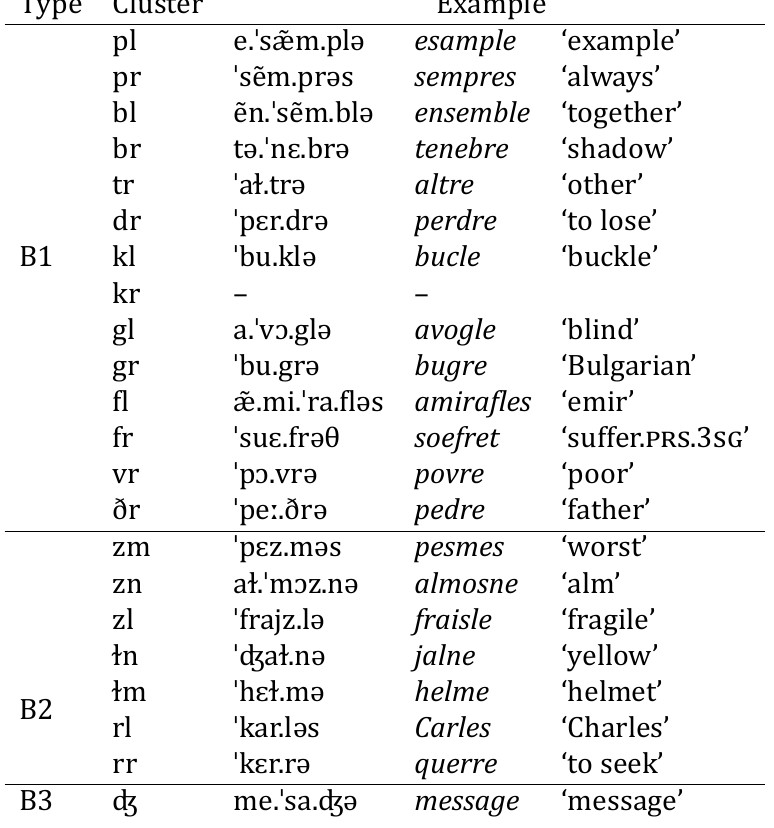
Table 2: Type B: Clusters attested in ˈV(C)__ə# but not ˈV(C)__# contexts.